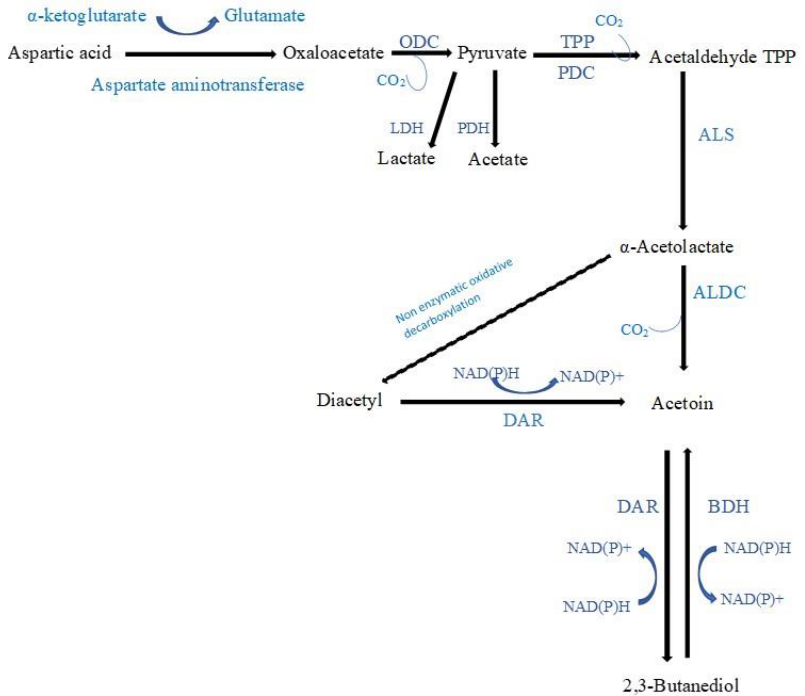
Figure 4. Catabolism of aspartic amino acid by Lactococcus lactis. ODC: oxaloacetate decarboxylase, LDH: lactate dehydrogenase, PDH: pyruvate dehydrogenase, PDC: pyruvate decarboxylase, TPP: thiamine pyrophosphate, ALS: α -acetolactate synthase, ALDC: α -acetolactate decarboxylase, DAR: diacetyl acetoin reductase, and BDH: 2,3-butanediol dehydrogenase [67].